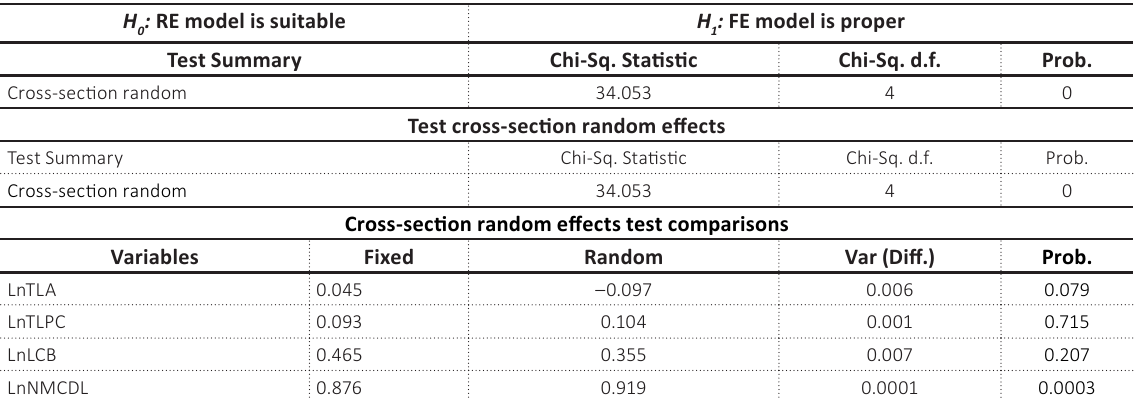
Table 4. Selection of Fixed Effect (FE) or Random Effect (RE) method H : RE model is suitable 0